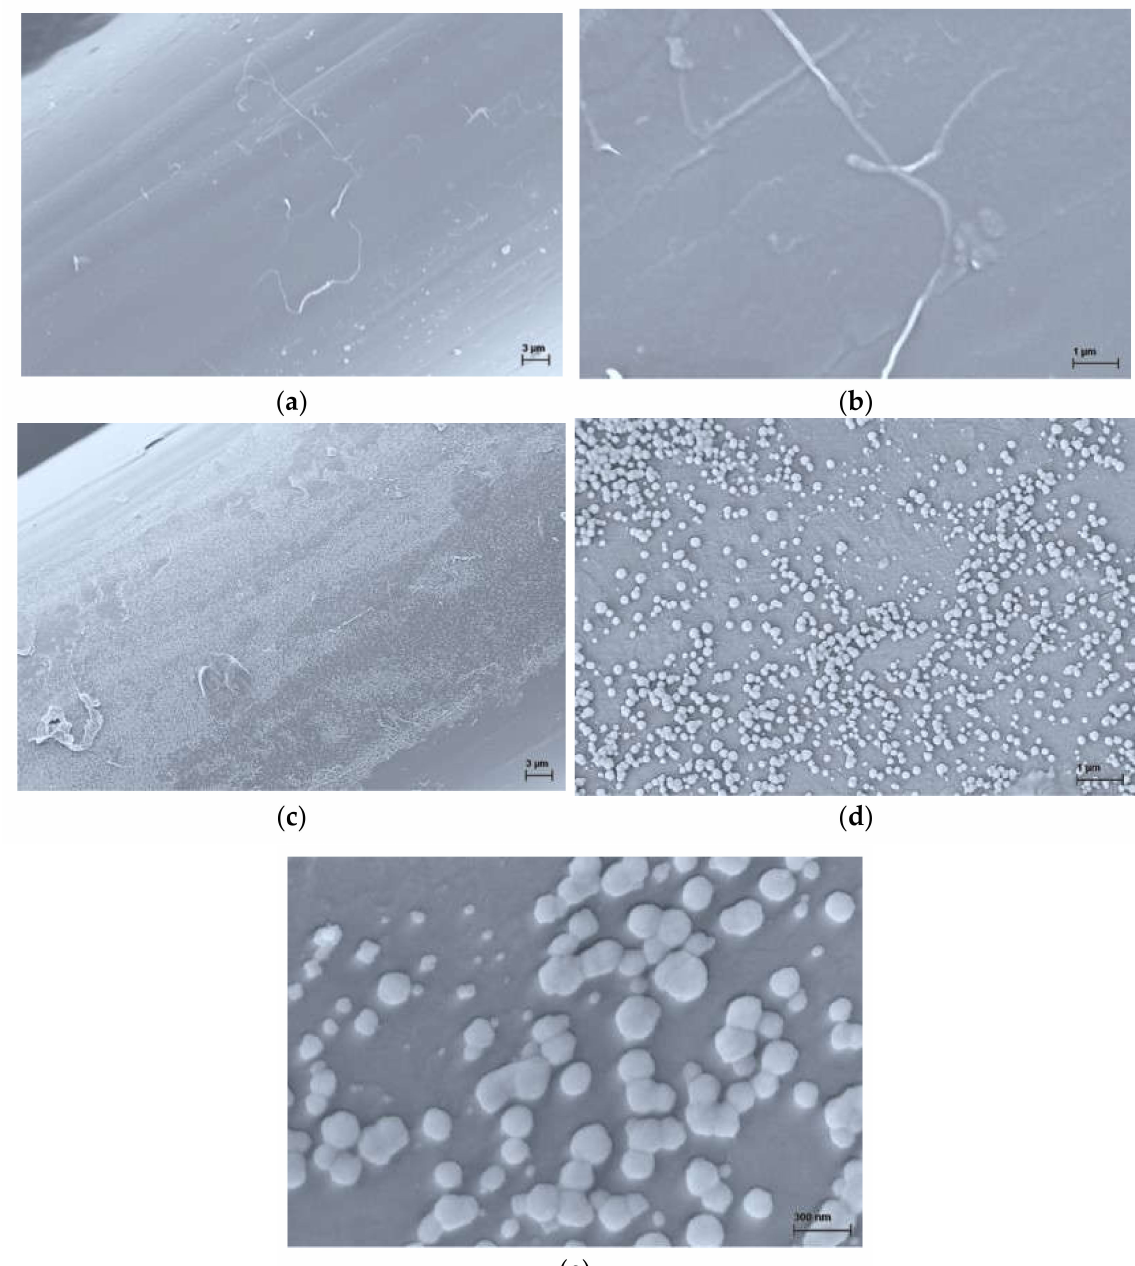
Figure 4. Representative SEM images of the surface morphology of the PA6 fibers after incubation of E. coli (( a , b ) at magnification factor/working distance of 5000 × /4.0 mm and 25,000 × /4.0 mm, respectively) and S. Aureus , (( c – e ) at magnification factor/working distance of 5000 × /4.0 mm, 25,000 × /4.1 mm and 100,000 × /4.1 mm,